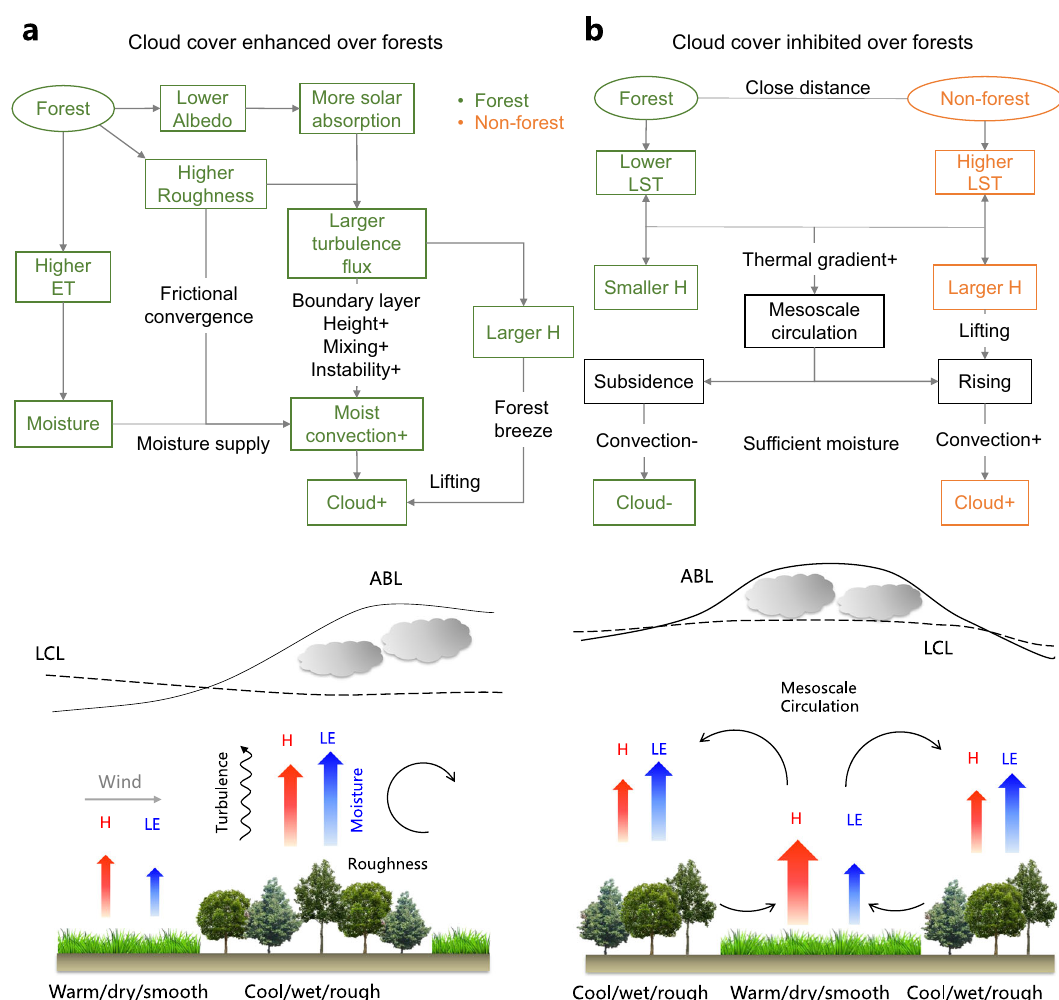
Fig. 4 Mechanisms of contrasting cloud effects of forests. a Clouds enhanced over forests through increased convection due to increased moisture supply and turbulence. b Clouds inhibited over forests through suppressed convection due to divergence of mesoscale circulations. ABL atmospheric boundary layer, LCL lifting condensation level, LE latent heat, H sensible